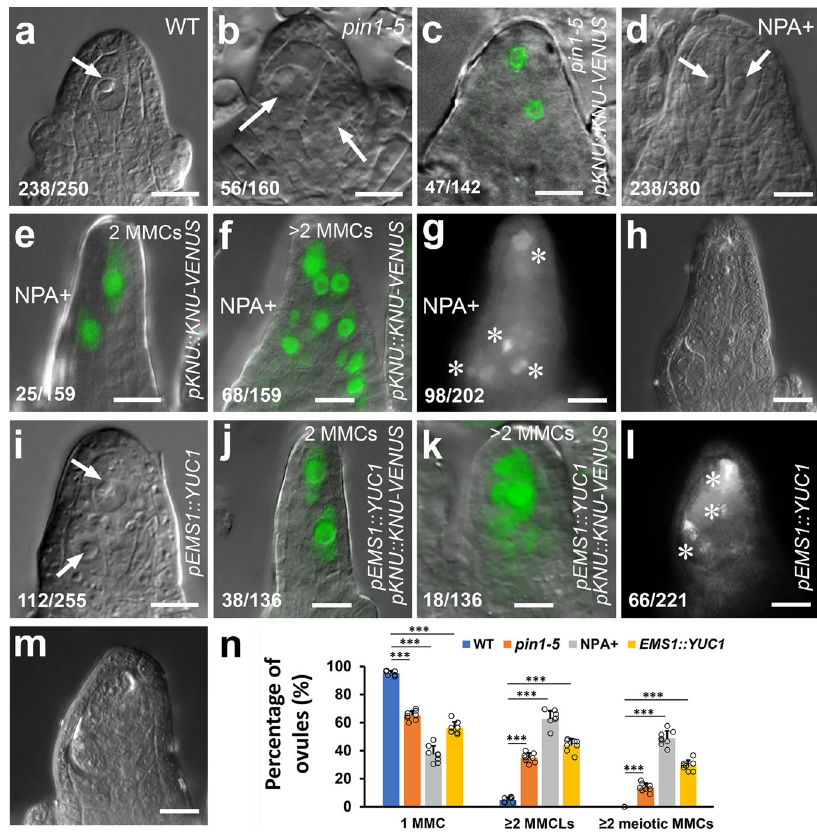
Fig. 4 | Manipulation of auxin signaling alters MMC speci fi cation. a – c Loss-of- function of PIN1 causing supernumerary MMCLs. DIC images showing one MMC (arrow)inWT( a )andtwoMMCLs(arrows)in pin1-5 ( b )ovules. c Amergedconfocal and DIC image of the pin1-5 ovule expressing pKNU::KNU-VENUS showing two MMCLs. d – h Inhibiting polar auxin transport by NPA resulting in supernumerary MMCLs and MMCs. d A DIC imageshowing twoMMCLs(arrows) inthe 4-day NPA- treatedWTovule. e , f MergedconfocalandDICimagesof4-dayNPA-treatedovules expressing pKNU::KNU-VENUS marking the MMC fate. e 2 MMCLs. f >2 MMCLs. g , h Callose deposition (denoted by white asterisks) showing multiple